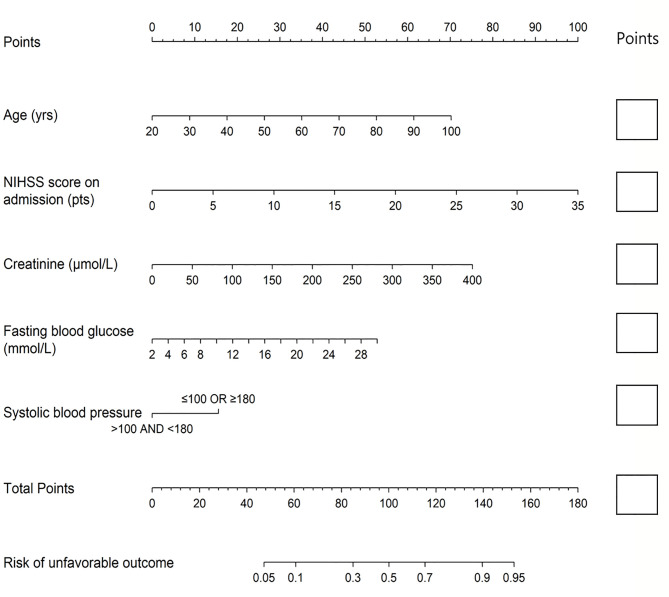
The nomogram used for predicting 1-year unfavorable outcomes in Chinese AIS patients. The final score (i.e., total points) is calculated as the sum of the individual score of each of the five variables included in the nomogram. AIS, acute ischemic stroke; NIHSS, National Institutes of Health Stroke Scale.